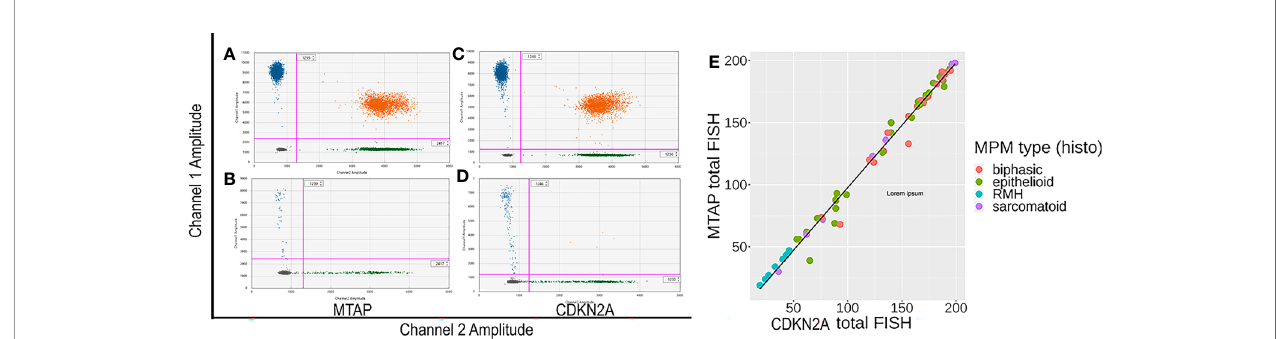
FIGURE 3 | (A – D) Representative images of methylthioadenosine phosphorylase (MTAP) and CDKN2A droplet digital PCR (ddPCR) analyses. (A, C) are control samples with both targeted region (MTAP or CDKN2A) retained. (B, D) are patient formalin fi xed paraf fi n embedded (FFPE) samples showing all positive populations are detectable. In samples having genomic (MTAP or CDKN2A) deletion, the top left population (blue) disappears while the reference population (green) remains. (E) Correlation between CDKN2A ddPCR results and MTAP ddPCR results for MPM and negative control normal pleural tissue samples, with line of linear regression